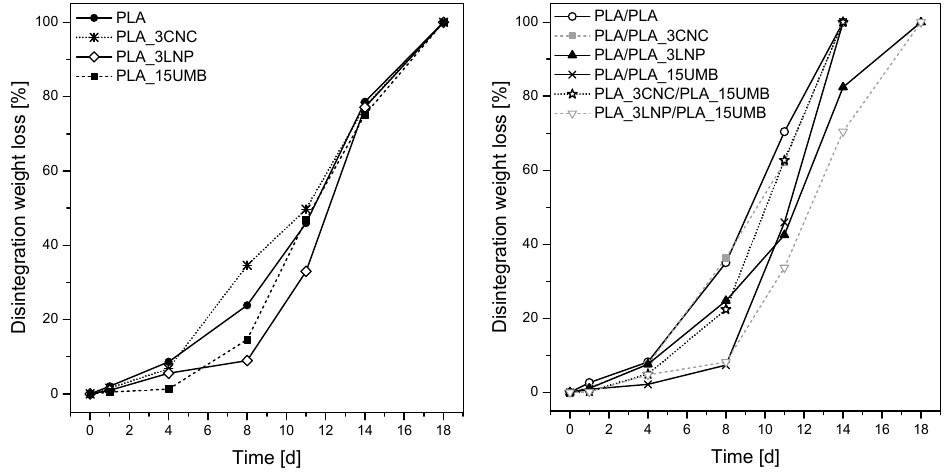
Figure 3. Disintegrability percentage values of PLA (neat and nanocomposites) monolayer ( left ) and bilayer ( right ) films at different stages of incubation in composting conditions.